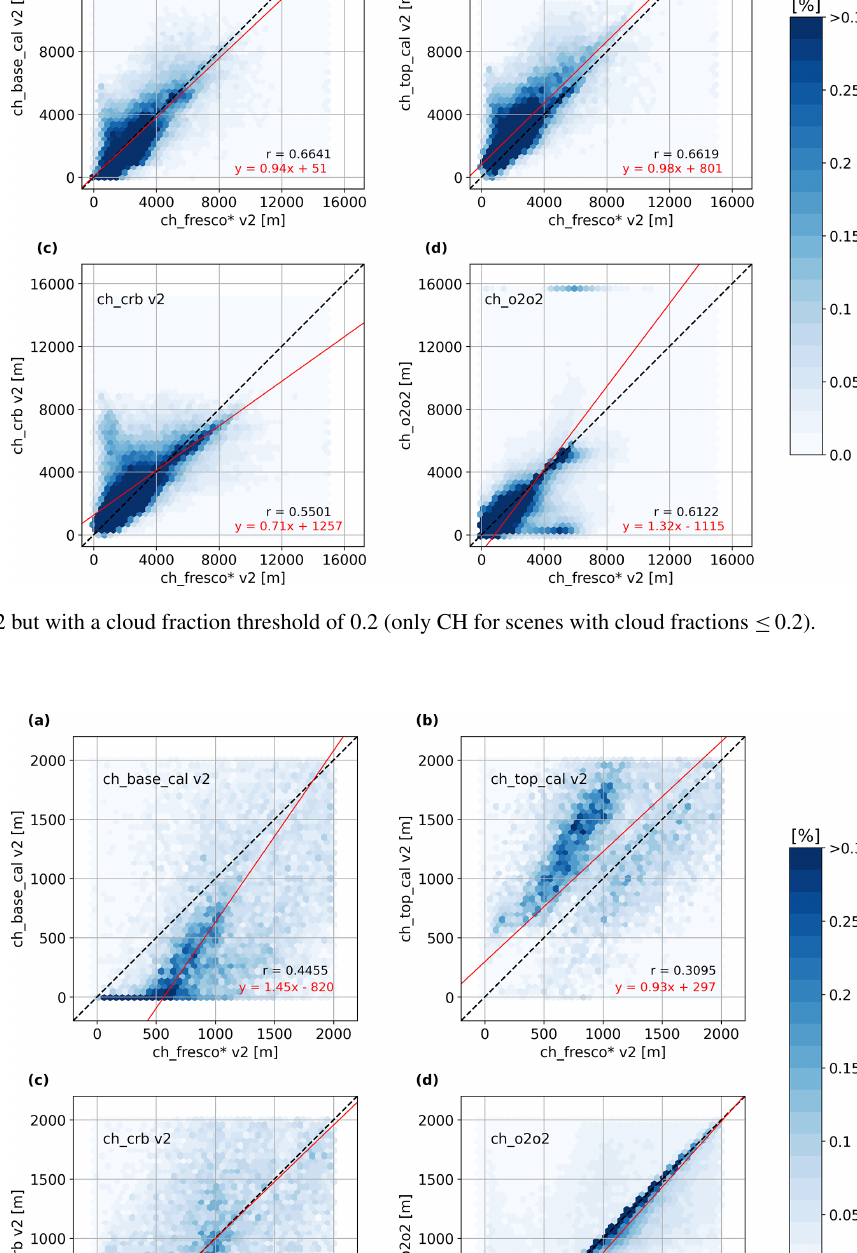
Atmos. Meas. Tech., 15, 6257–6283, 2022